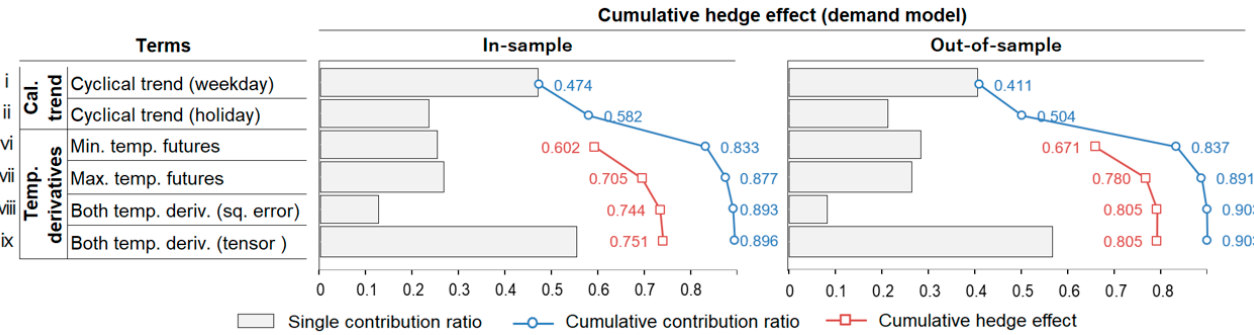
Figure 11. Contribution ratio and hedge effect of demand model.